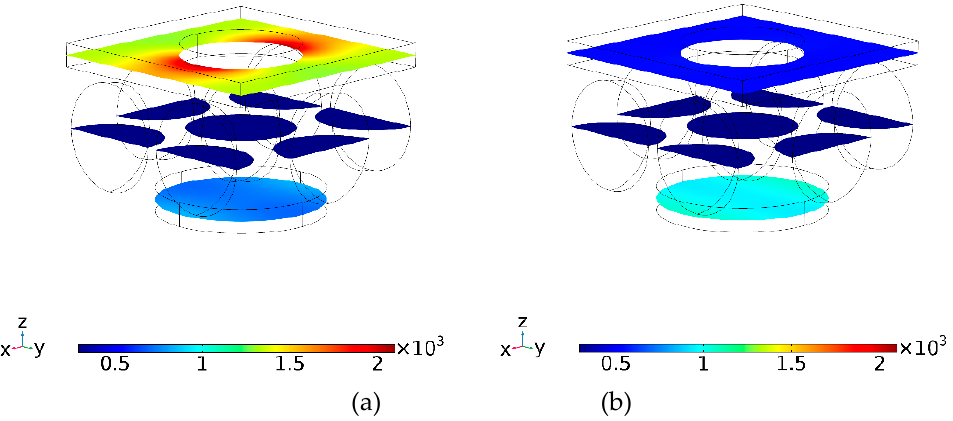
Figure 7. Temperature distribution in Kelvins ( o K) after 1 ns at peak electromagnetic absorption wavelength of ( a ) λ = 1.24 microns and ( b ) λ = 1.33 microns when the gap is filled with air/silica spheres.